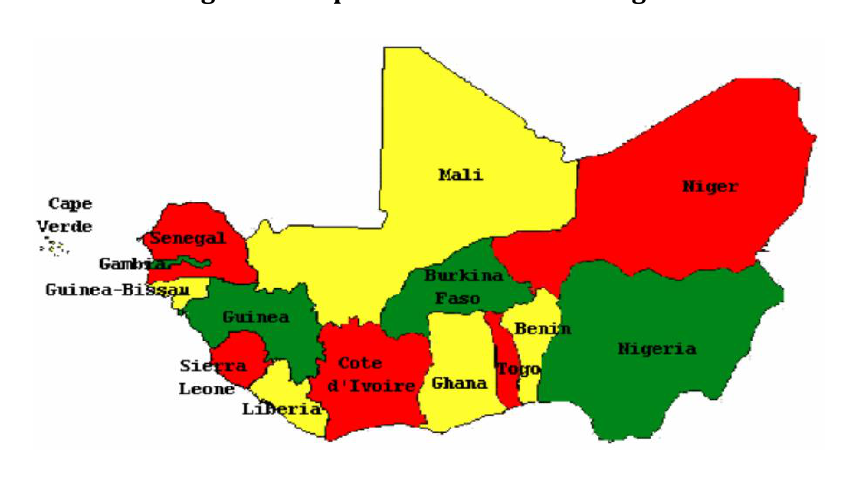
Figure 1: Map of the ECOWAS